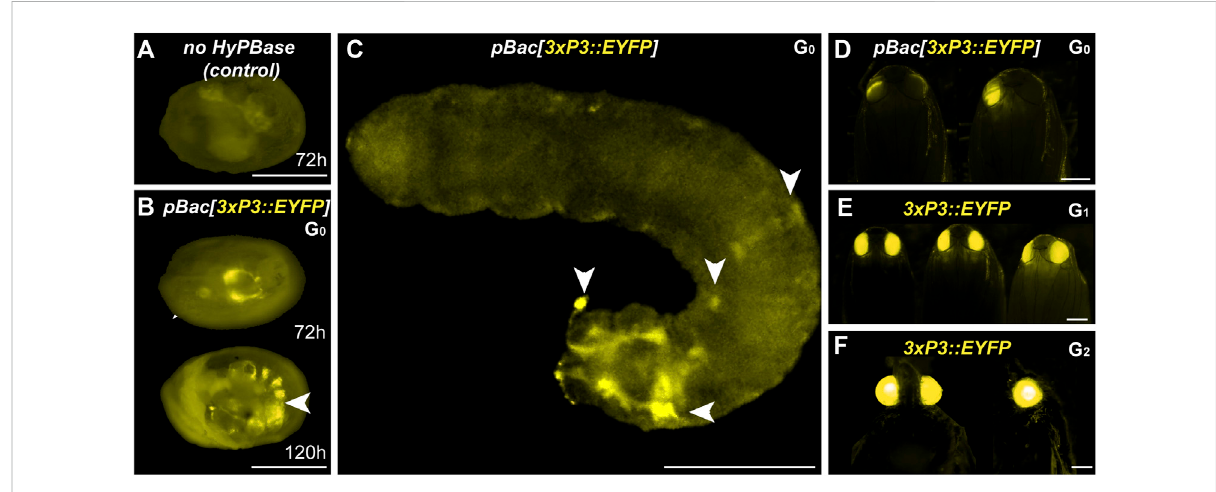
FIGURE 4 Somatic and germline transgenesis of 3xP3::EYFP in Plodia . (A) Weak background auto fl uorescence in the EYFP observation channel following control injection of the donor plasmid only. (B) Somatic activity of 3xP3::EYFP transgenes at 72 h and 120 h post injection in the late egg stage (C) MosaicG 0 3xP3::EYFP expressionina fi rstinstarlarva,markinggliaandocellarstemmata(arrowheads). (D) MosaicG 0 3xP3::EYFP expressioninpupal eyes. (E) 3xP3::EYFP expression in G 1 Plodia pupae. (F) Ventral (left) and lateral views (right) of 3xP3::EYFP expression in G 2 Plodia adults. Scale bars: A-C = 200 μ m; D-F = 500